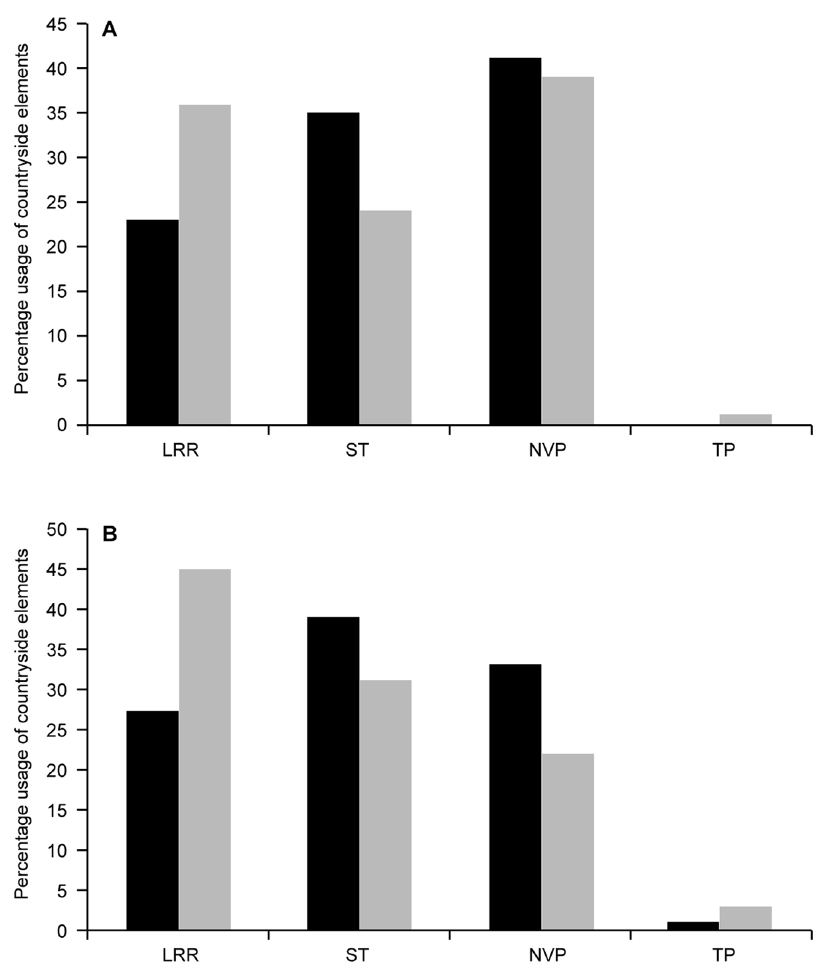
Figure 3. Actual usage verse the predicted usage of countryside elements. LRR = Linear roadside remnants, ST = Scattered trees, NVP = Native vegetation patches, TP = Tree plantings. Actual percentage usage is shown as black shading and the predicted percentage usage is shown as grey shading. Panel (a) is based on diurnal fixes, and Panel (b) is based on nocturnal fixes.